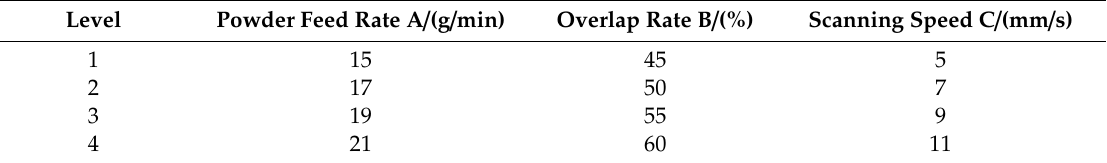
Table 3. Orthogonal test level and factor design.